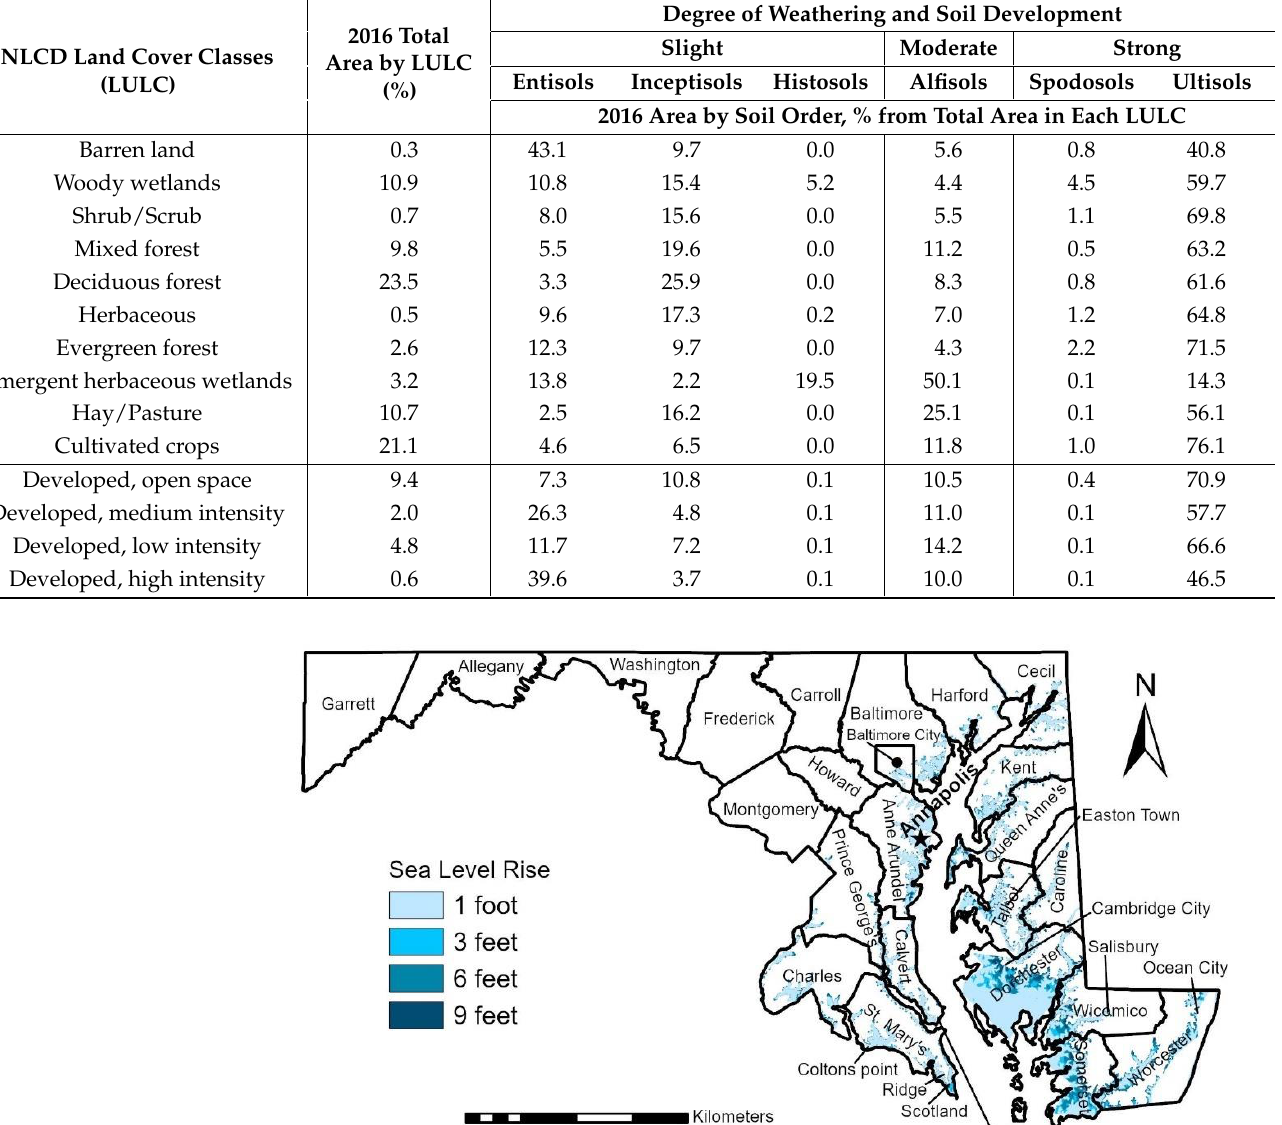
Table 9. Land use/land cover (LULC) by soil order in Maryland (USA) in 2016.